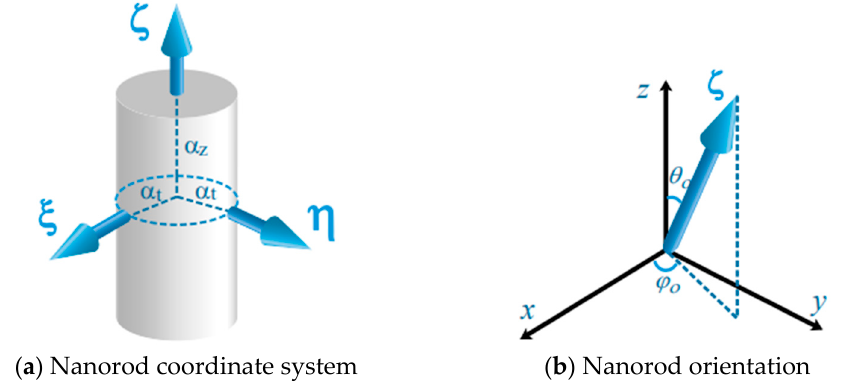
ξ ζ η , , ) and the angle between θ , θ ϕ y , z ) coordinate system ( 0 0 ). 0 represents the angle ϕ represents the angle between the projection